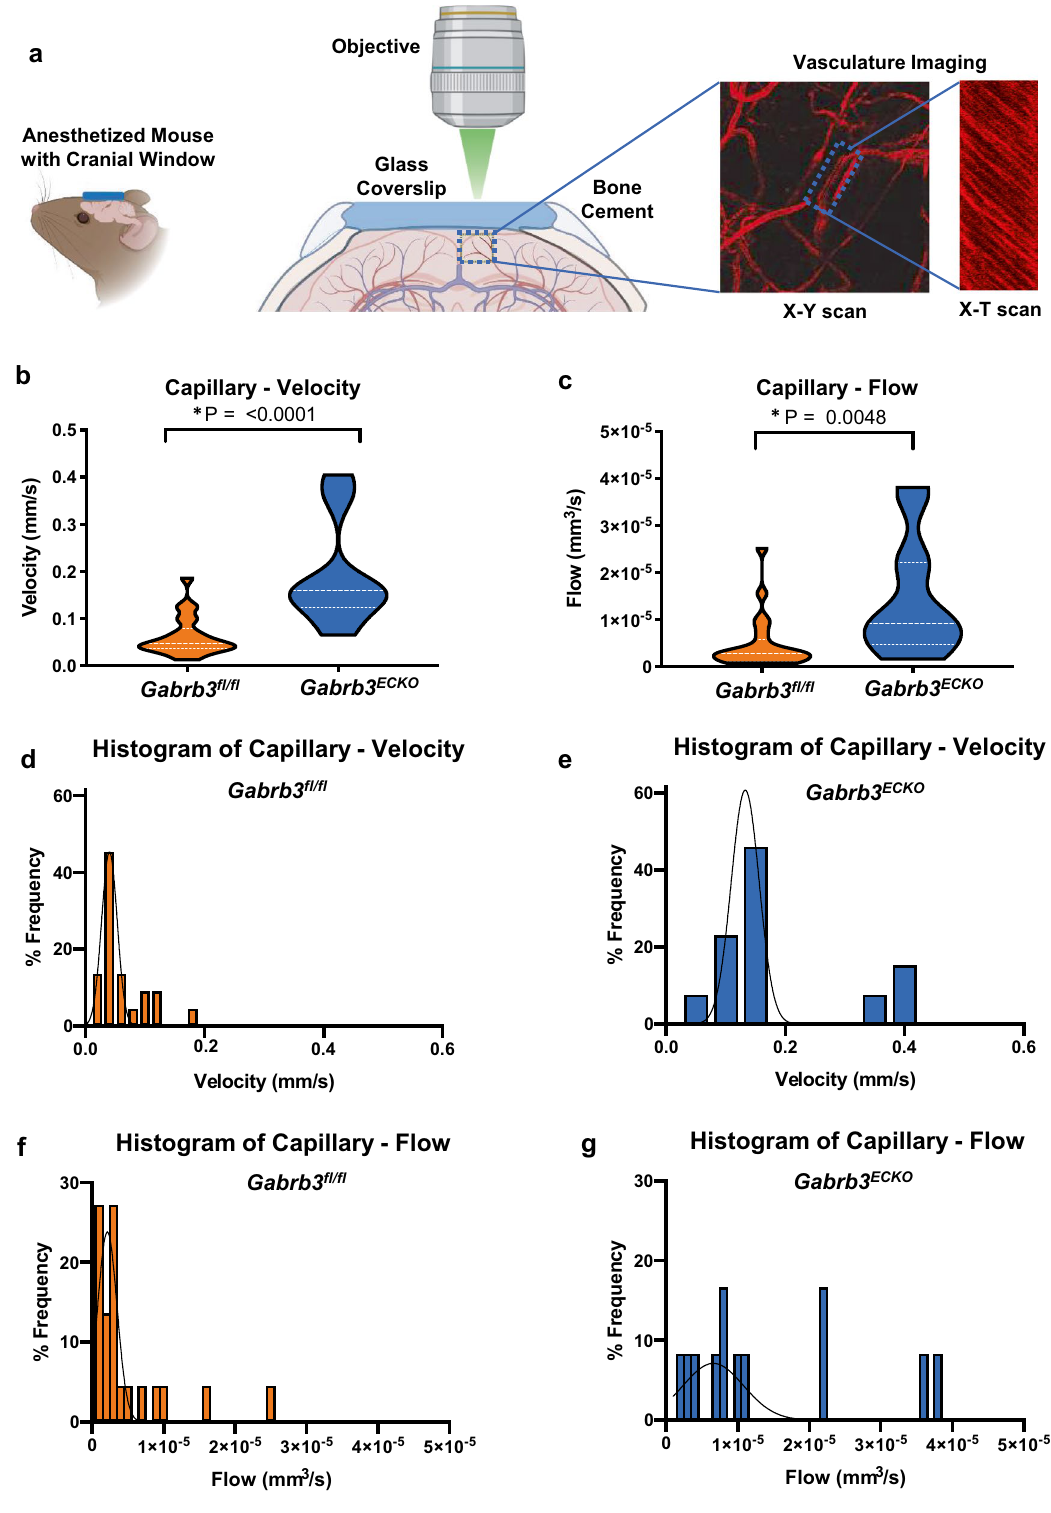
Figure 1. Blood flow changes in Gabrb3 ECKO mice. ( a ) Schematic of blood flow velocity acquisition by MPLSM. Using TAMRA–dextran contrast enhanced angiography; region of interest is first identified. Then, line scan images along the central axis of individual blood vessels (x-t) are acquired. Dark streaks (negative contrast) correspond to RBCs moving along the central axis of the blood vessel. The slopes of these streaks correspond to the RBC velocities. Data are presented in violin plots (*P < 0.05, Student’s t-test). ( b ) Violin plot showing distribution of RBC velocities in capillaries (n = 22, n = 13 vessels, respectively). ( c ) Violin plot showing distribution of blood flow in capillaries of Gabrb3 fl/fl and Gabrb3 ECKO mice (n = 22, n = 12 vessels, respectively). ( e–g ) Histograms of RBC velocity and blood flow in the capillaries in the Gabrb3 fl/fl versus Gabrb3 ECKO